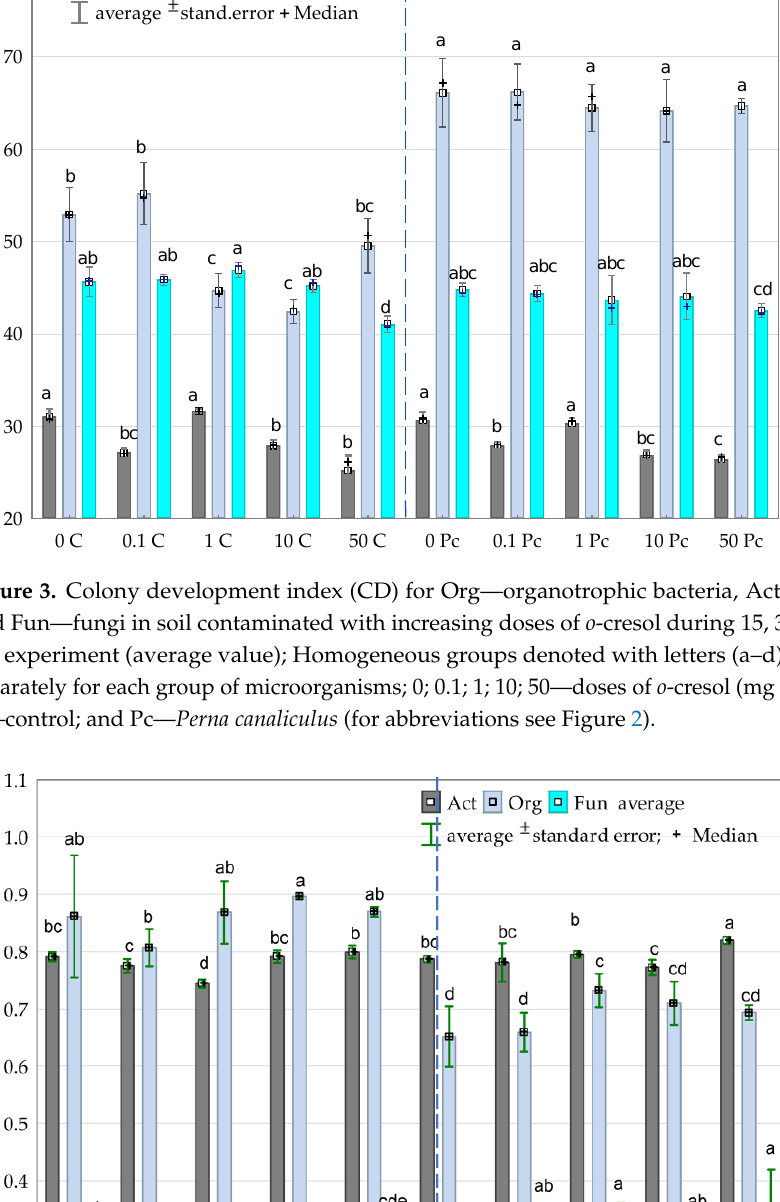
Figure 2. Number of microorganisms in soil contaminated with o -cresol on day 15, 30 and 45 of the experiment (cfu 10 n kg −1 DM of soil); Org—organotrophic bacteria (10 9 ), Act—actinomycetes (10 9 ), F—mold fungi (10 7 ), Ps— Pseudomonas sp. (10 8 ), Art— Arthrobacter sp. (10 8 ), Im—nitrogen-immobi- lising bacteria (10 8 ), Am—ammonifying bacteria (10 8 ) and Az— Azotobacter sp. (10 3 ). Homogeneous groups are specified in columns, for each group of microorganisms, depending on the increasing doses of o- cresol on T1—15 day, T2—30 day, T3—45 day of the experiment are denoted with letters mussel had no stimulating effect on the rate of fungal multiplication, yet it increased fungal (a–e), r—Pearson’s linear correlation coefficient, * significant for p = 0.05, n = 14.